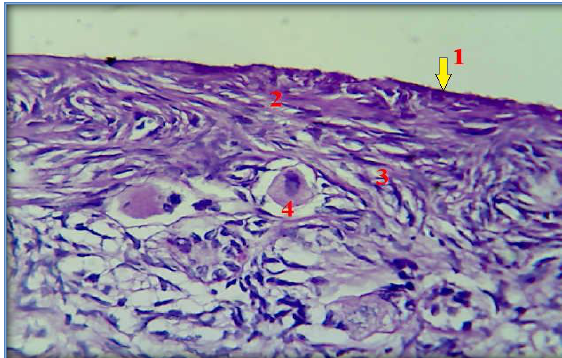
Figure, 2: Histological section in ovary of one animal in group (B) shows simple squamous germinal epithelium (1) over tunica albuginea (2), and the cortex (3) that contain primordial follicle (4) (H and E stain 100X) .